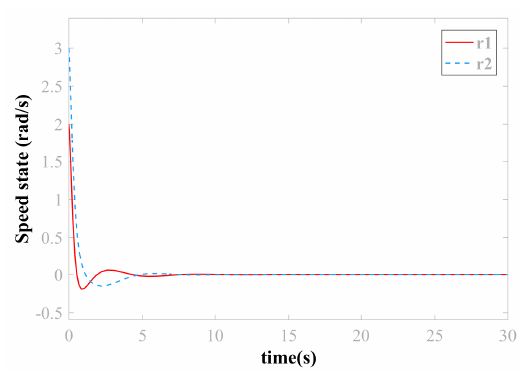
Figure 6. Yaw angrular speed state of two ships ( r 1, r 2 )